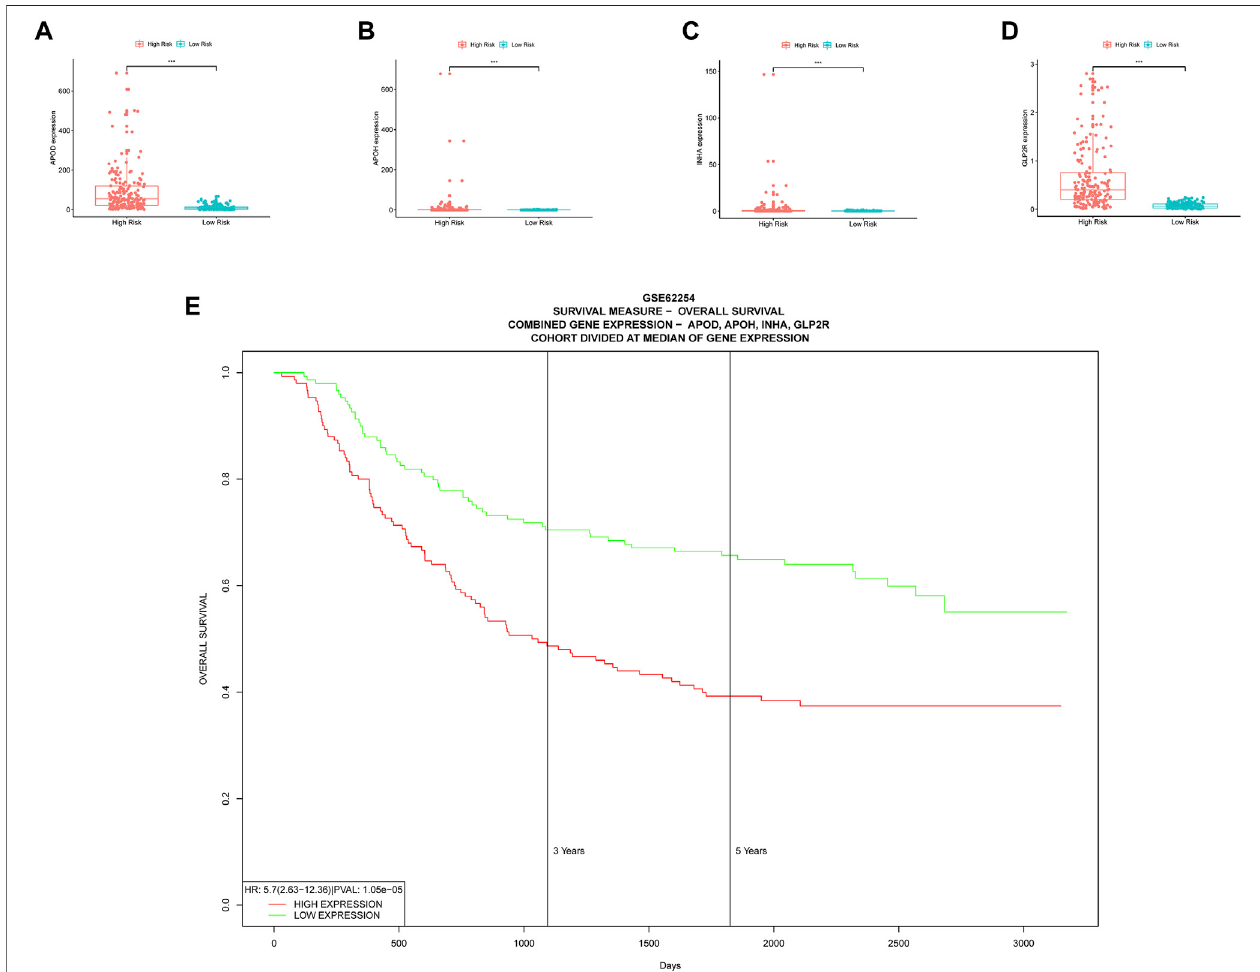
FIGURE 7 | Multiple validations of model genes. (A – D) Boxplots display the differential expression for model genes. *, p < 0.05. **, p < 0.01. ***, p < 0.001. (E) Multiple gene survival validation, from the PROGgeneV2 online tool.